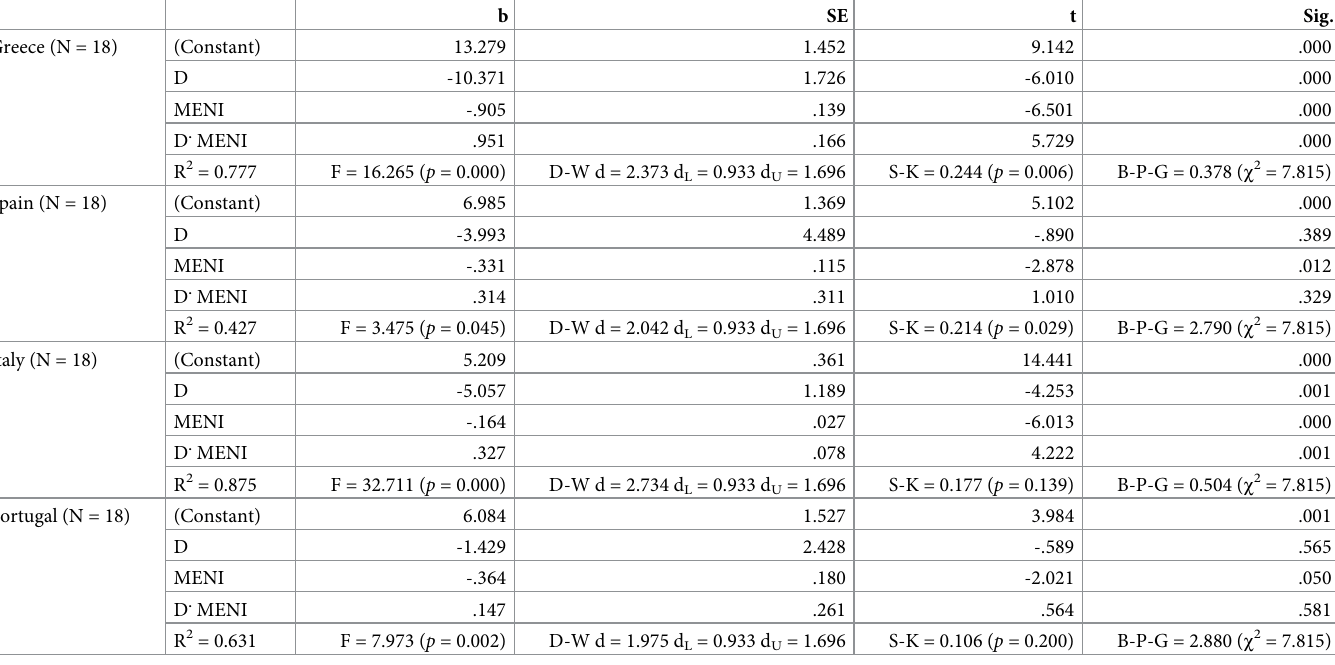
Table 5. Regression results by country: Explanatory variable is Median Equivalised Net Income (MENI) PPP-adjusted.